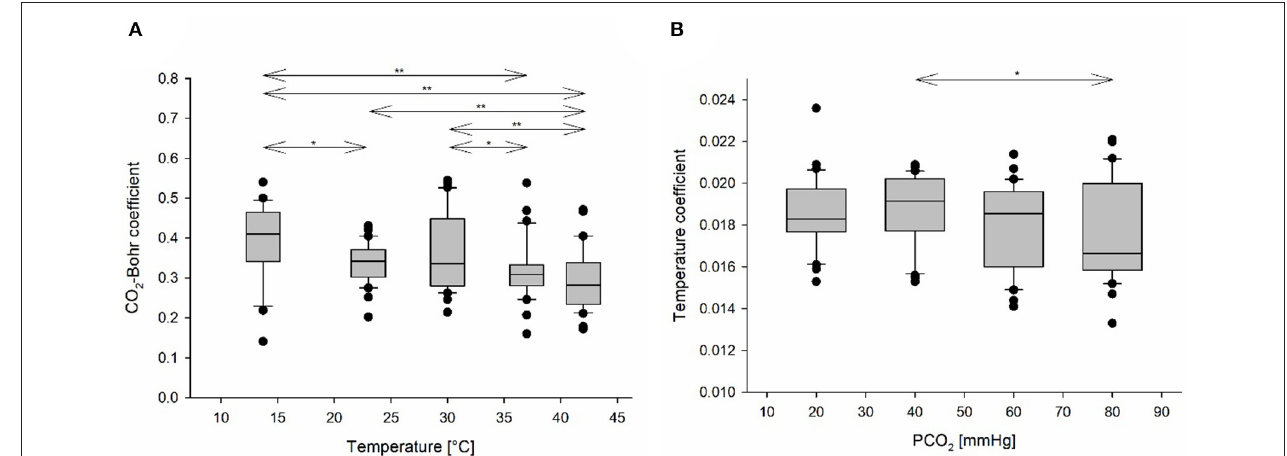
FIGURE 5 | (A) CO 2 -Bohr coefficients (CO 2 -BCs) in relation to temperature, presented as boxplots. CO 2 -BC, a measure of relative CO 2 -Bohr effect, decreases with increasing temperature. (B) Temperature coefficients (TCs) in relation to PCO 2 , presented as boxplots. Black circles represent outliers. A line with arrows and asterisks indicates a pairwise comparison which was detected as statistically significant by the LMM; one asterisk denotes 0.05 ≤ p < 0.1, and two asterisks denote p < 0.05.